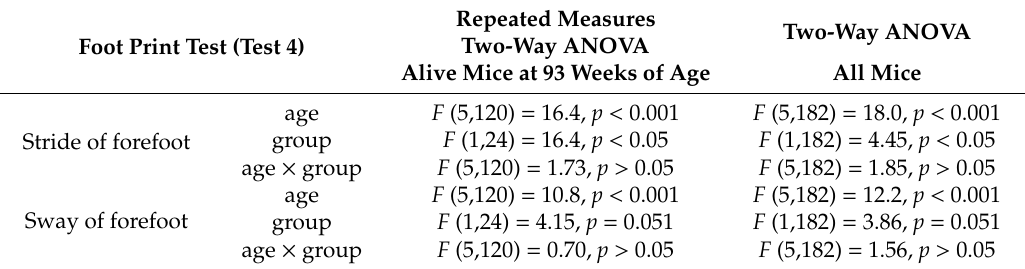
Table 2. Results of statistical analysis in Test